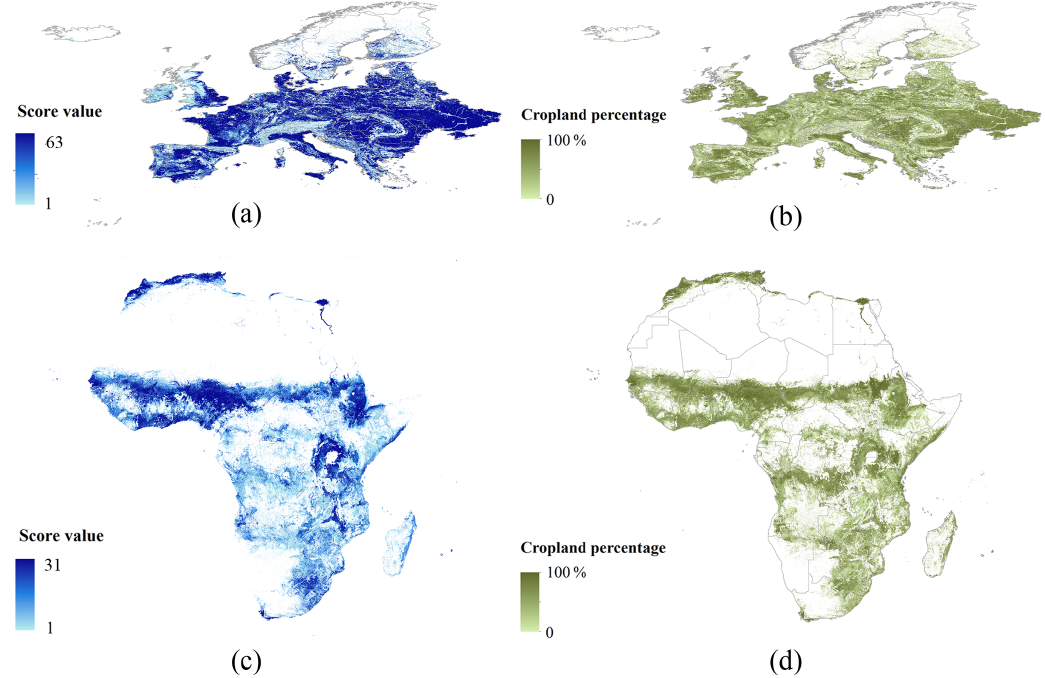
Figure 4. Agreement-ranking score maps and average cropland percentages in Europe and Africa: (a) and (b) are the score map and cropland percentage of Europe; (c) and (d) are the score map and cropland percentage of Africa.